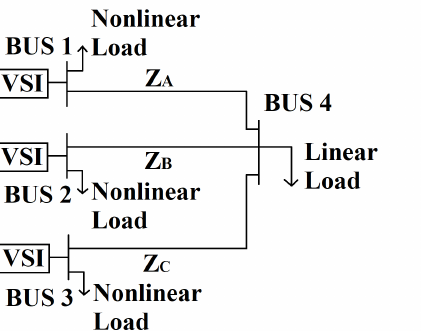
Figure 13. Reactive power injected at Buses 2 and 3 (comparison of the SMC and PI controls).